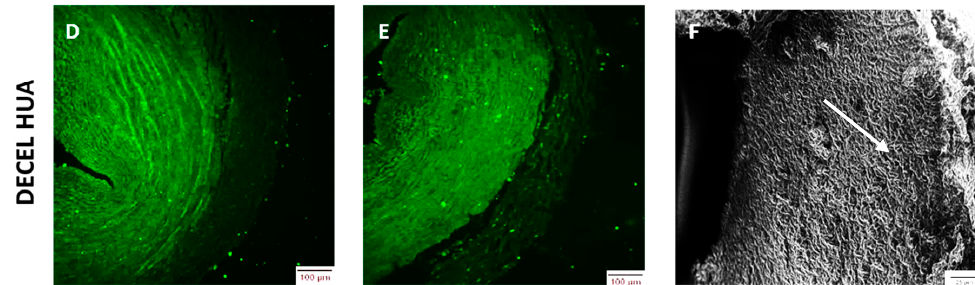
Figure 3. Indirect immunofluorescence and scanning electron microscopy (SEM) analysis in human umbilical arteries (hUAs). Indirect immunofluorescence against collagen type I ( A , D ) and fibronectin ( B , E ) in combination with DAPI staining in native and decellularized (decel) hUAs, respectively. Blue spots in images A and B represent the presence of cell nuclei. Images were obtained with original magnification 10 × and scale bars 100 µ m. SEM analysis of native ( C ) and decellularized ( F ) hUAs. White arrows in image C, indicate the presence of cellular populations. White arrows in image F, indicate the preservation of ECM proteins, while no cellular populations are evident. Images were obtained with original magnification 40× and scale bars 25 μ m.